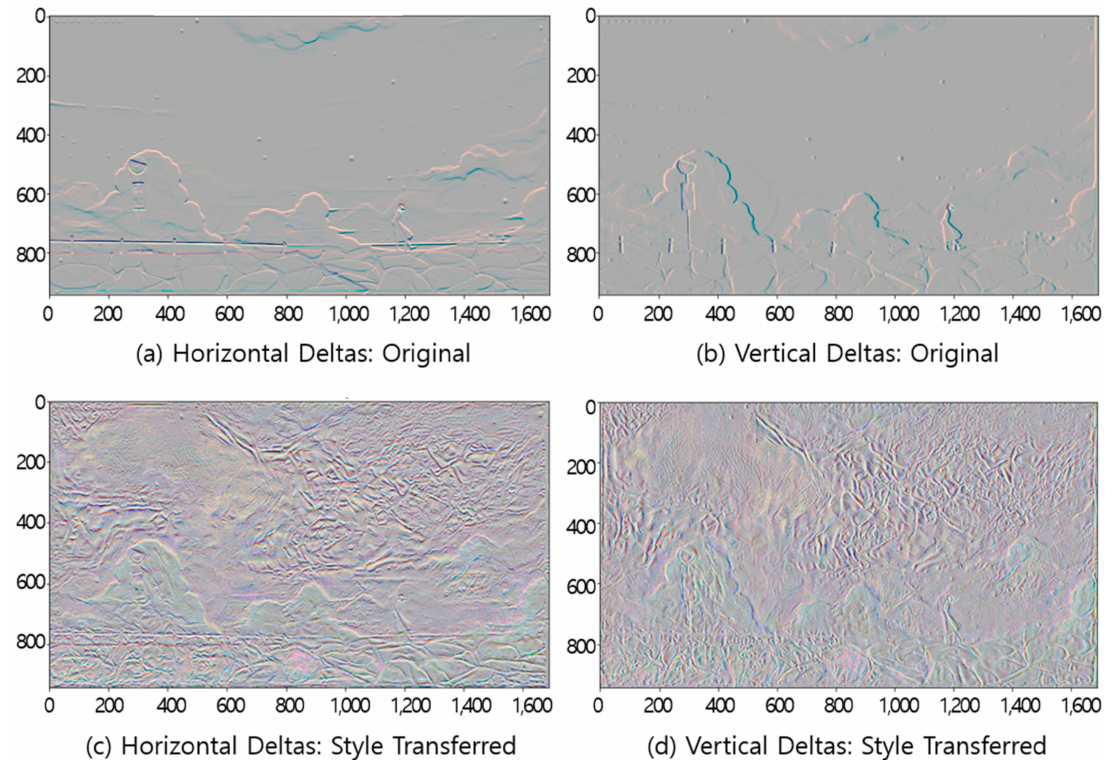
Figure 10. Results of losing content features problem.